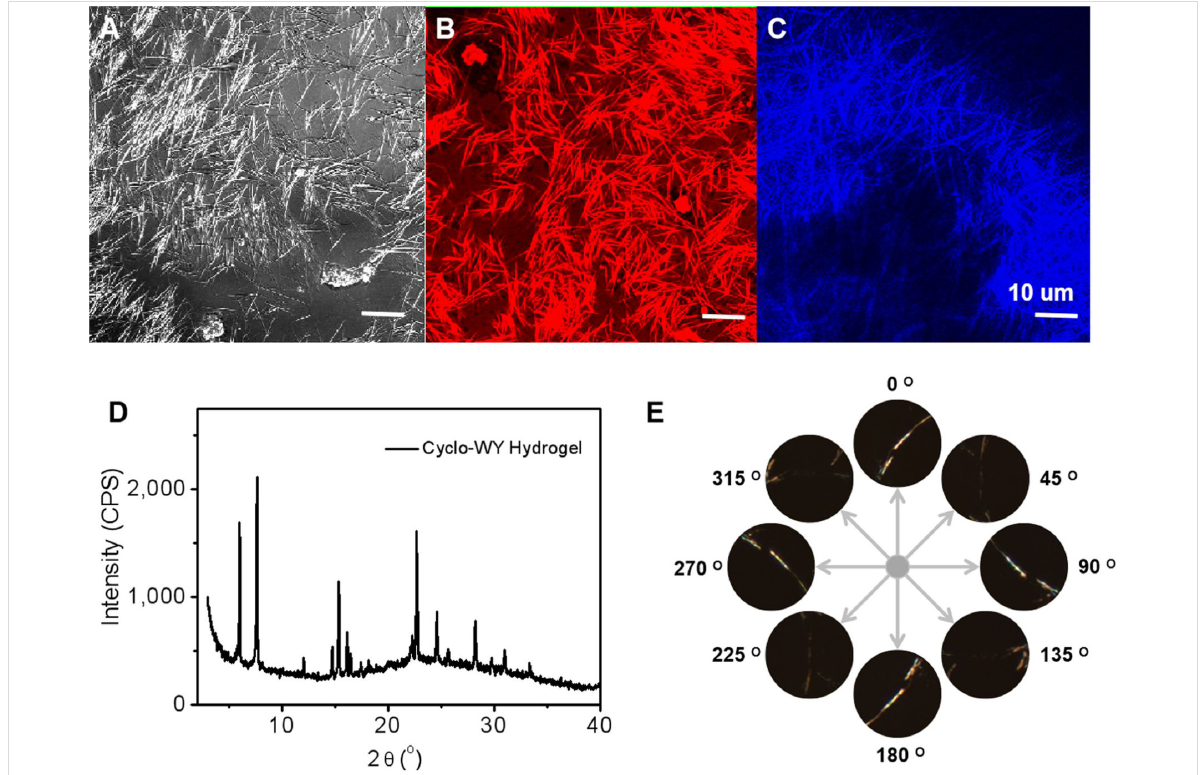
Figure 2: Interior structure and crystal pattern. (A) CLSM images of the C-WY hydrogel in light field. NR was used to indicate the formation of hydro- phobic domains (red color, B) and ThT was used to indicate the beta-sheet secondary structures (blue color, C). (D) XRD pattern of the hydrogel. (E) POM images in cross-polarized light mode of samples taken at